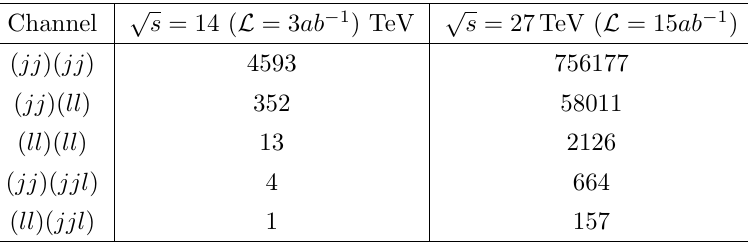
Table 7 . Number of events computed using (cid:27) and 27 TeV ( = 15ab (cid:0) 1 ) at LHC before analysis cuts are applied. L